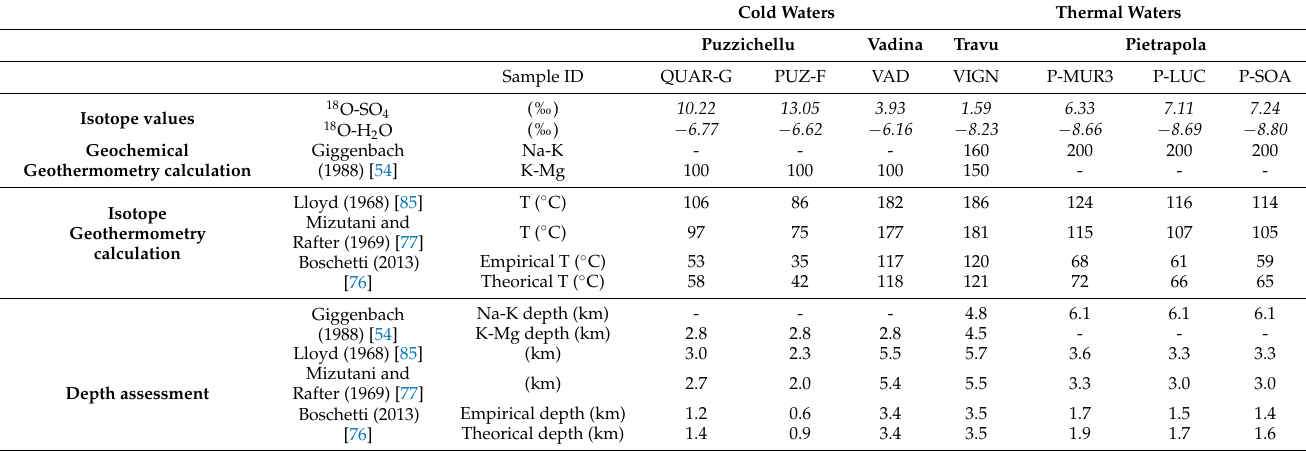
Table 6. Sulphates isotopes geothermometers calculation compared to geochemical geothermometry and flow depth